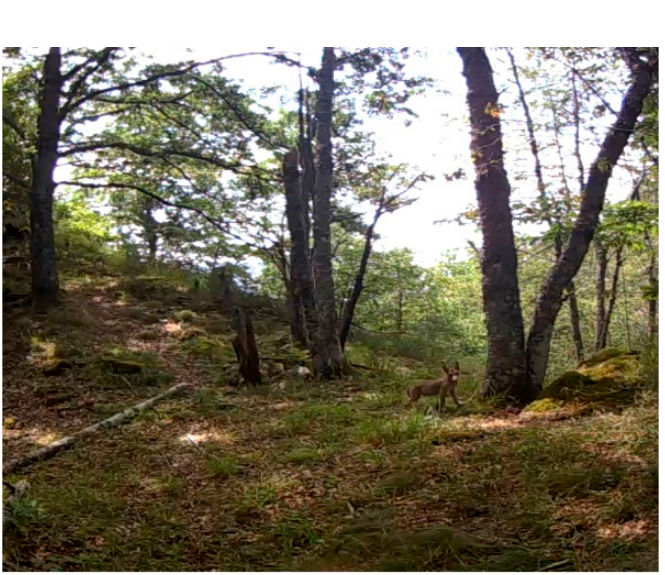
* For WH: area with detection of puppies. * For CT: area with detection of a group of at least three wolves. * For NGS: area with genotyped individuals. ** CT and NGS sampling can be performed on the same work day if camera traps are along the transects. Increased E ff ort Sampling Area = IESA.